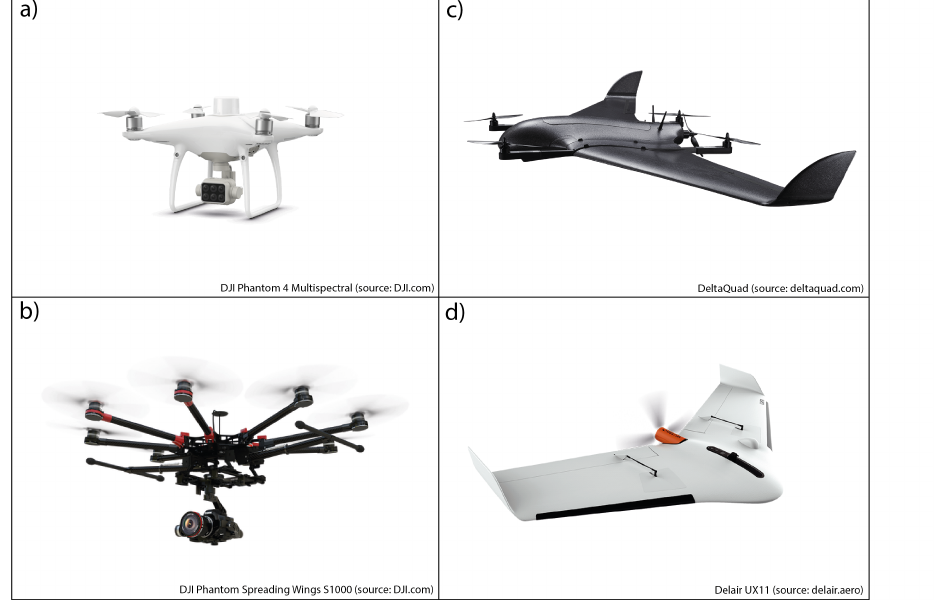
Figure 3. Different UAV types, commonly used for civilian applications: ( a ) rotary-wing (quadcopter), ( b ) rotary-wing (octocopter), ( c ) Hybrid VTOL solution, and ( d )